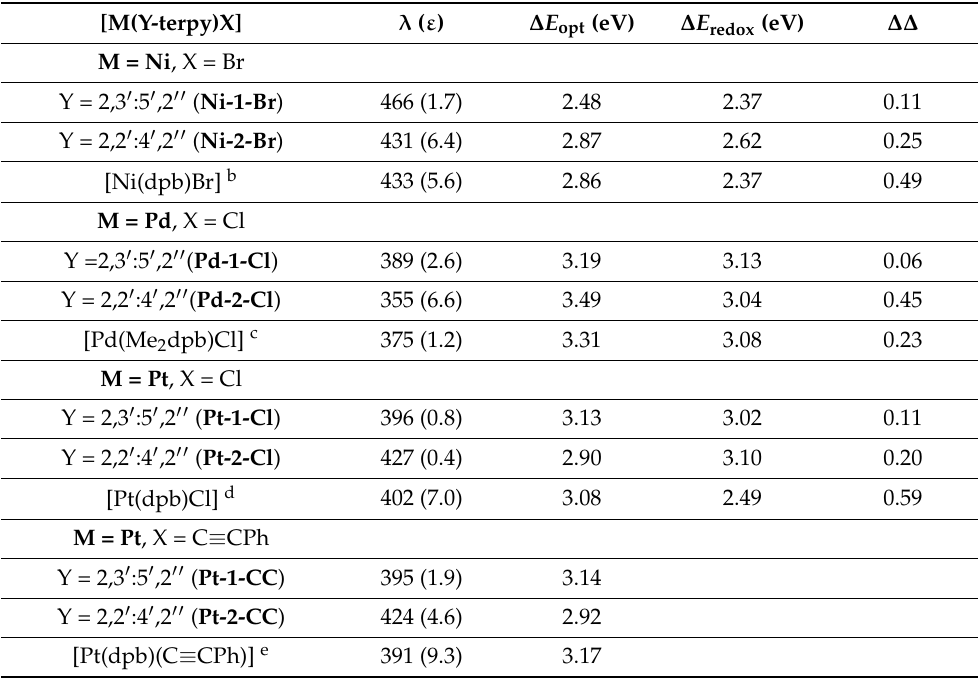
Table 3. Long-wavelength UV-vis absorption maxima and the optical and electrochemical gaps of complexes [M(Y-terpy)X] and related complexes a